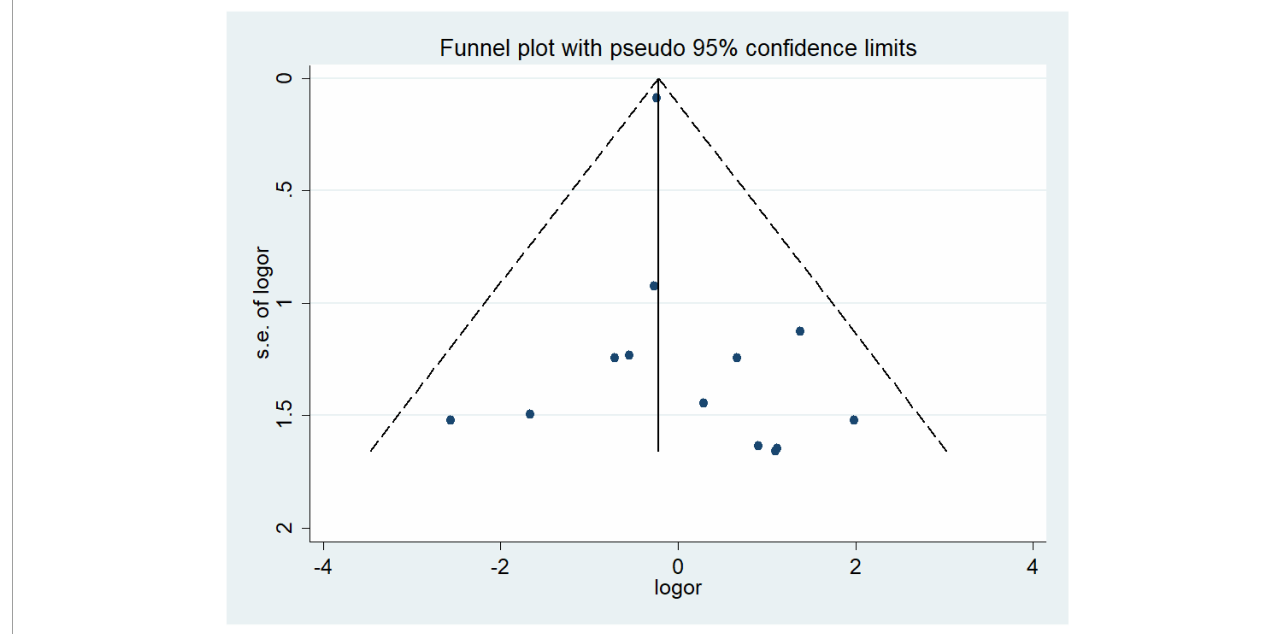
FIGURE20 Funnel plots for publication bias assessment in wound infections.